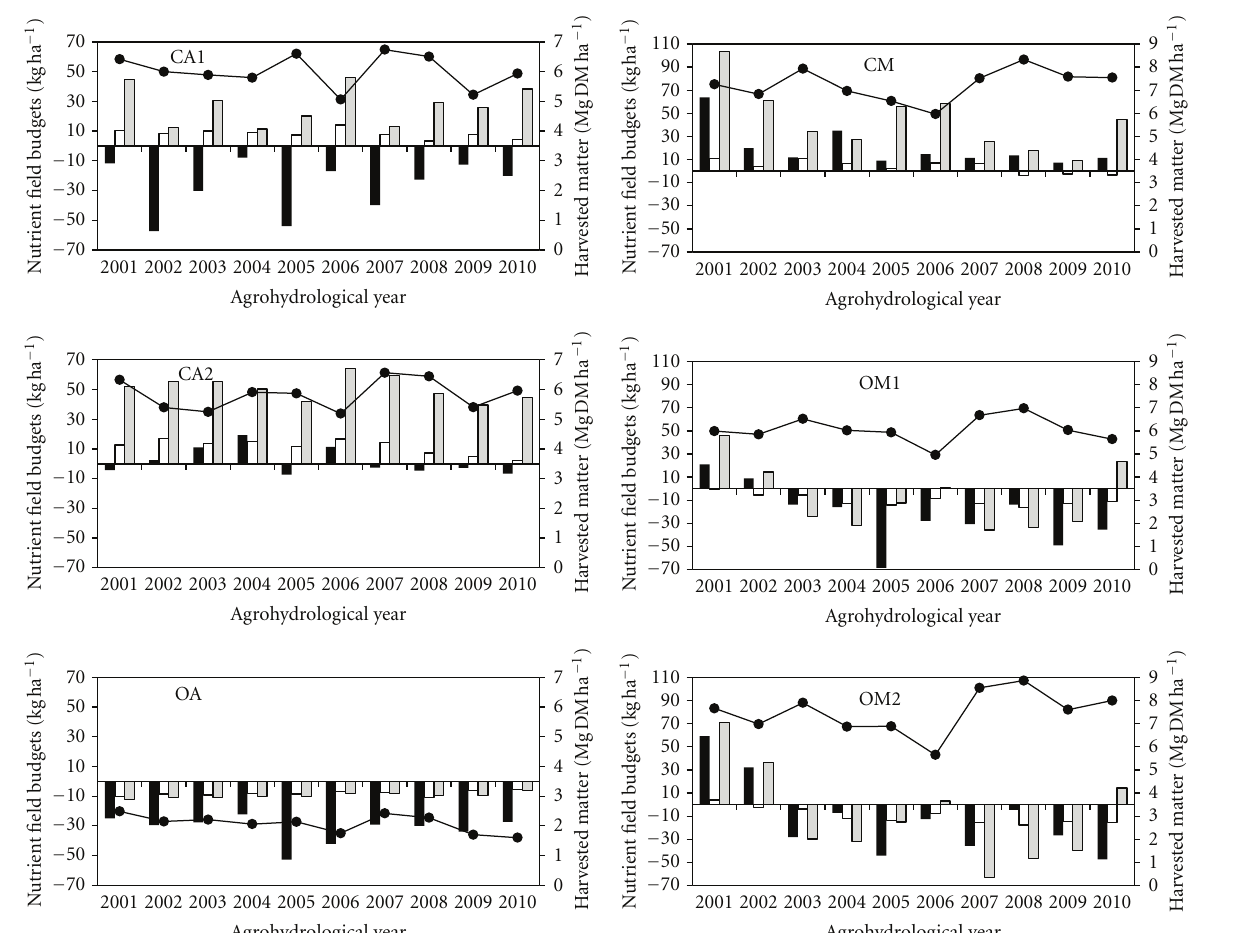
Figure 2: Annual (agrohydrological year) harvested dry matter yields averaged over crops (lines) (right y -axis) and soil system budgets for N (black bars), P (white bars), and K (grey bars) (left y -axis) for CA1 (conventional arable: upper left subplot), CA2 (conventional arable, environmentally sound: middle left subplot), OA (organic arable: lower left subplot), CM (conventional mixed dairy: upper right subplot), OM1 (organic mixed dairy: middle right subplot), and OM2 (organic mixed dairy with 75% clover ley: lower right subplot).